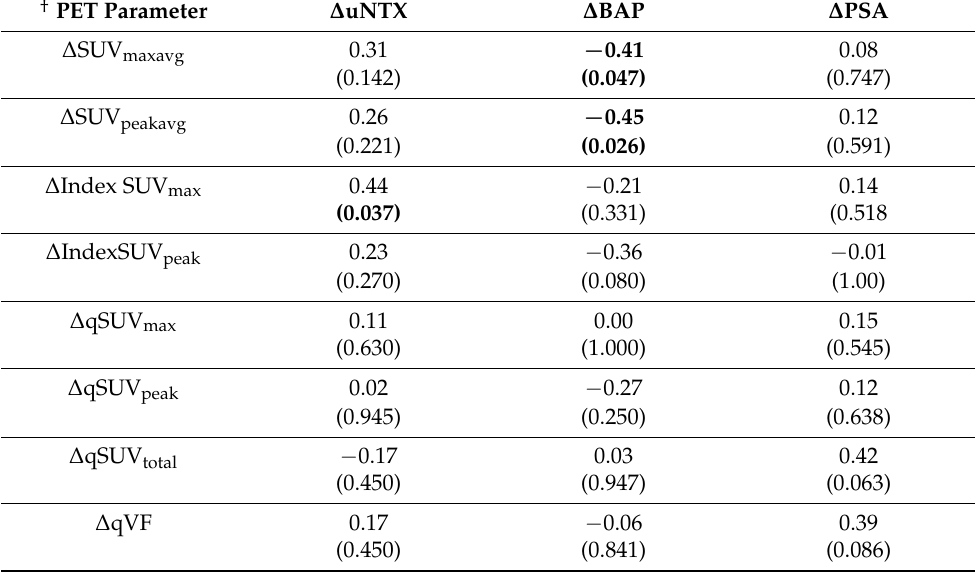
Table 5. Correlations between change of NaF PET parameters and change in